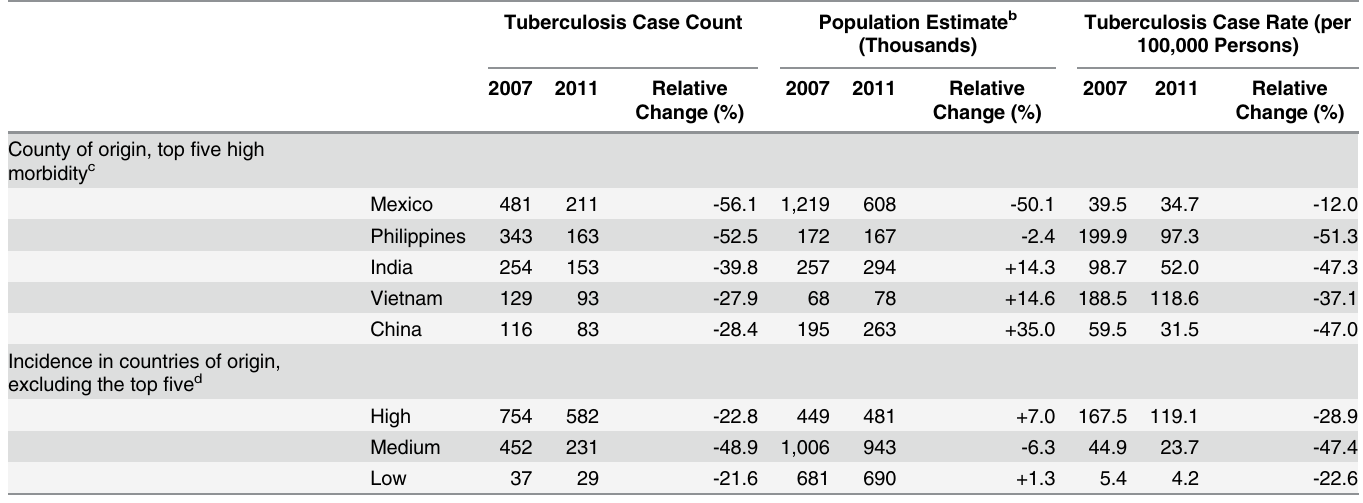
Table 2. Changes in tuberculosis case counts, population estimates, and tuberculosis case rates among recent a entrants, 2007 and 2011.